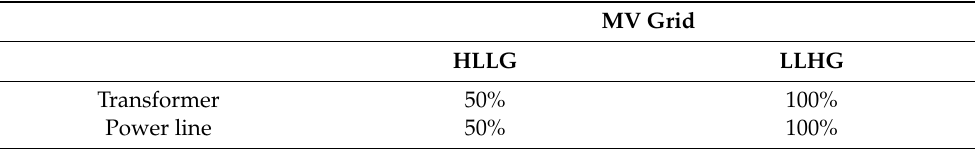
Table 2. Relevant equipment loading limits for the deterministic planning of MV grids [1].